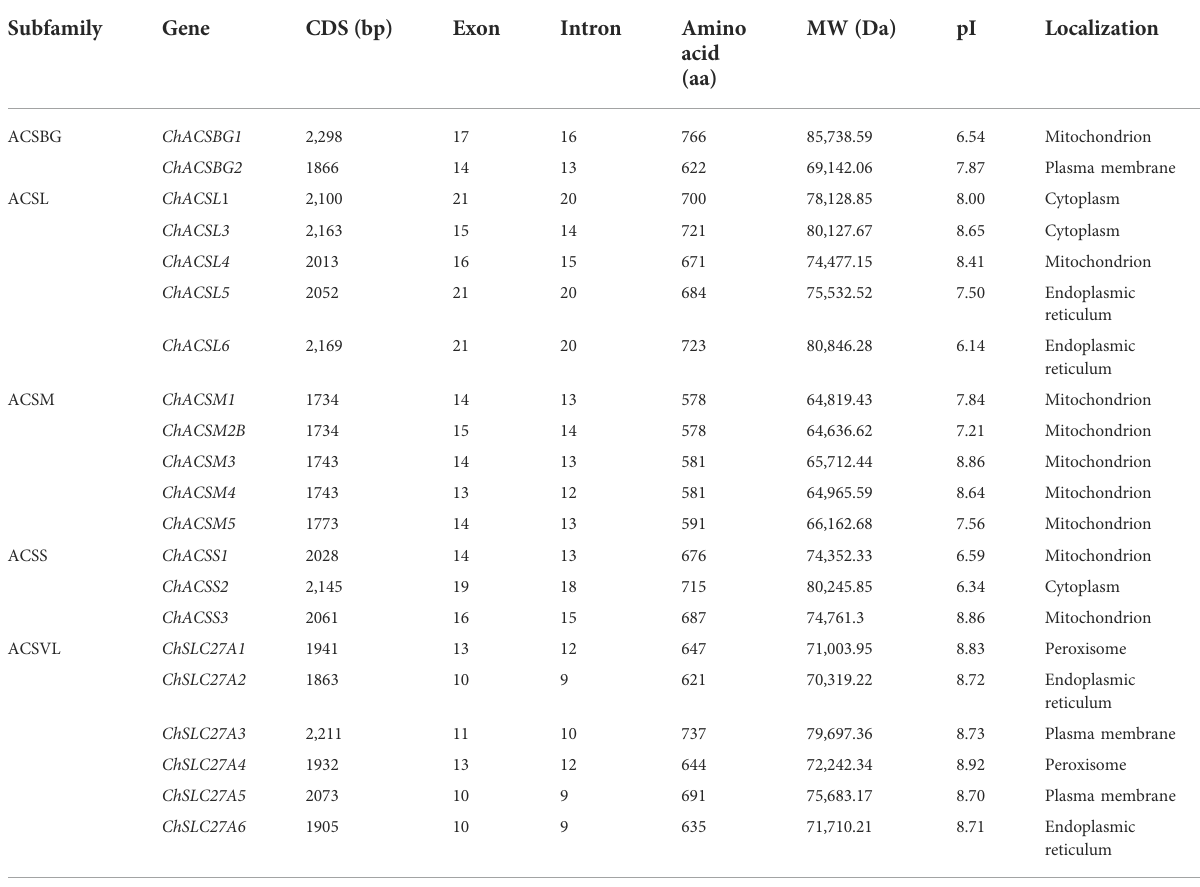
TABLE 1 Information of ACS family genes in goat. Subfamily Gene CDS (bp) Exon Intron Amino